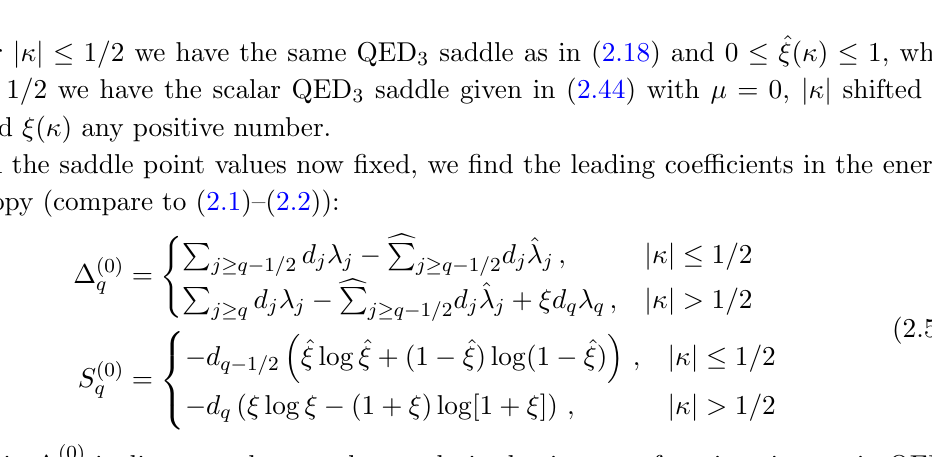
Figure 4 . The leading order coe(cid:14)cients (cid:1) (0) q and S (0) q of the scaling dimension and entropy of the lowest-dimension monopole operators for 1 = 2 (cid:20) q (cid:20) 2 in N = 1 SQED 3 , as a function of (cid:20) (cid:17) k=N